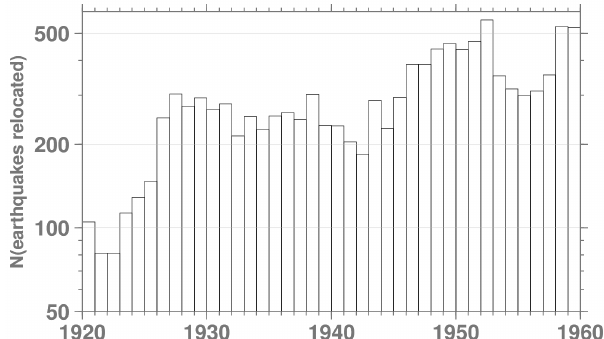
Figure 5. Box-and-whisker plot for the extension events of the me- dian number of stations supplying amplitudes per event in each year. The box represents the 25%–75% quantile, the band inside the box represents the median and the ends of the whiskers represent the minimum and maximum of all data.